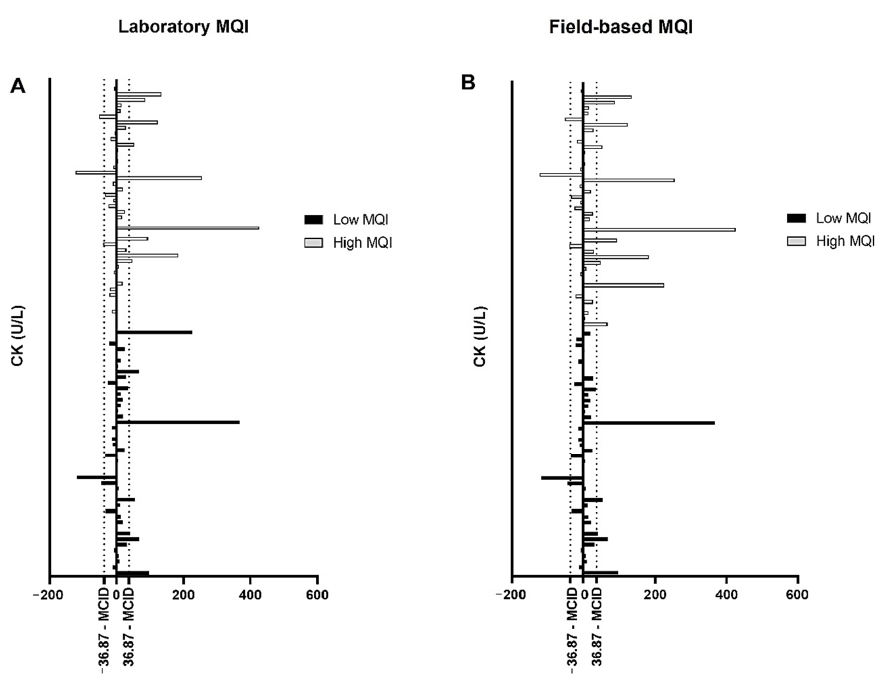
Figure 5. Responsiveness for creatine kinase (CK) levels based on minimal clinical important difference (MCID). ( A ) Laboratory CK levels; ( B ) field ‐ based CK levels